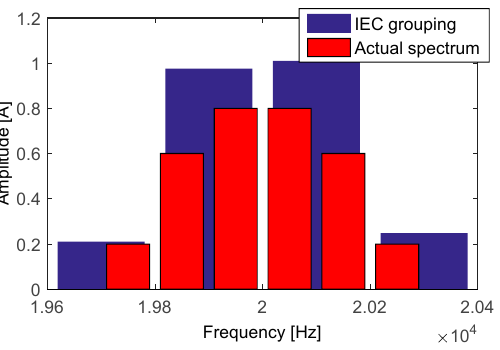
Figure 4. Case study 1: Comparison between high-frequency International Electrotechnical Commission (IEC) grouping and actual high-frequency spectrum.